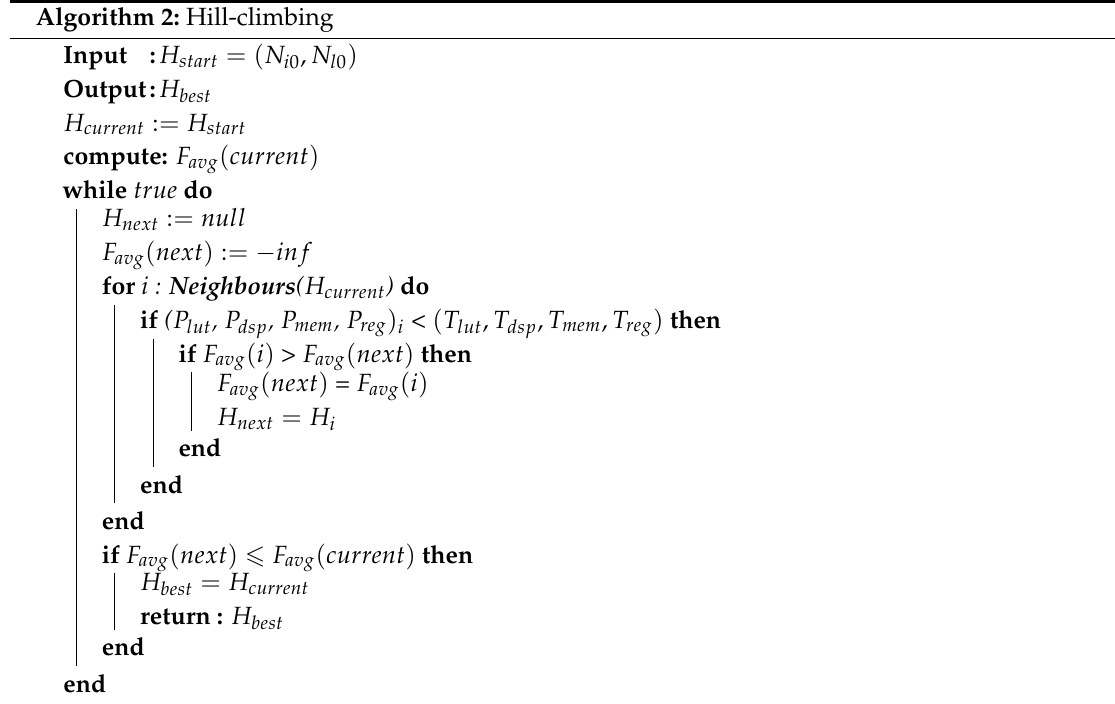
Figure 7. The hill-climber in a two-dimensional (2D) design-space. Optimizer O moves toward the direction that optimizes the cost function ∆